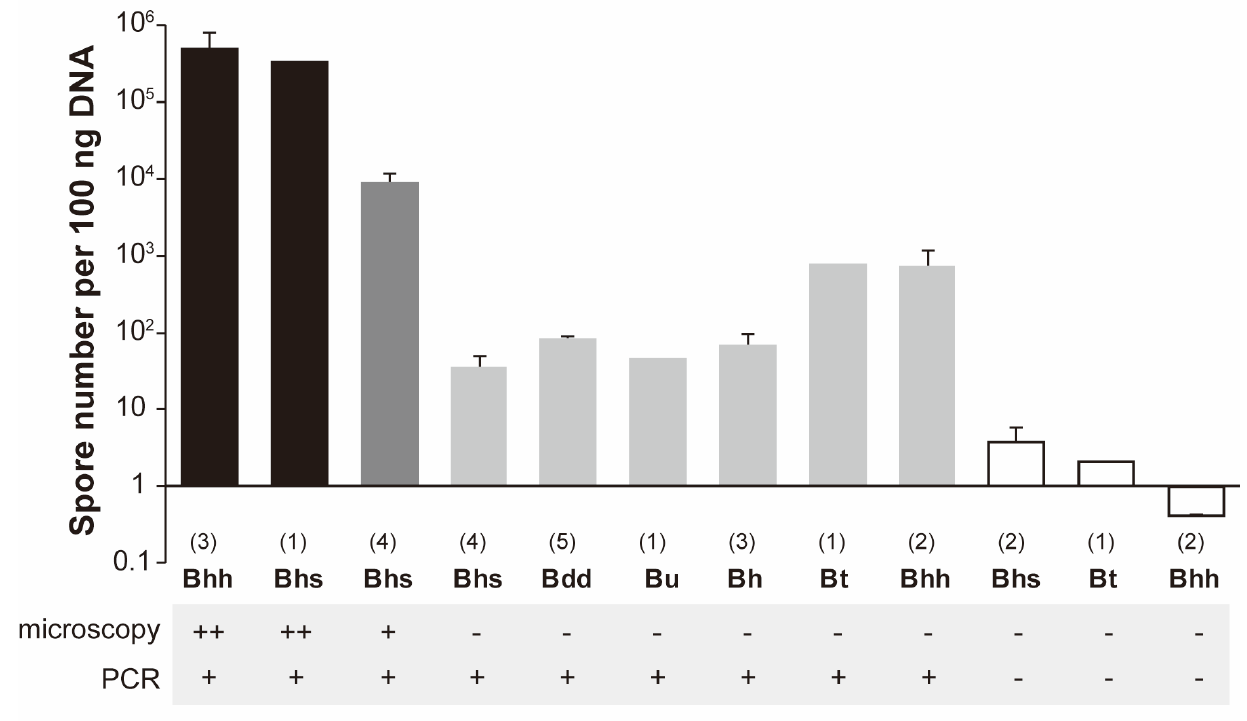
Figure 4. Spore numbers per 100 ng DNA as bar graph quantified using quantitative PCR in each bumblebee species and their Vairimorpha spp. infection statuses. Black bar indicates sporulating Vairimorpha spp. PCR-positive bumblebees (with more than five spores in a visual field); dark gray bar, sporulating Vairimorpha spp. PCR-positive bumblebees (with less than five spores in visual field); light gray bar, non/low-sporulating Vairimorpha spp. PCR-positive bumblebees; white bar,